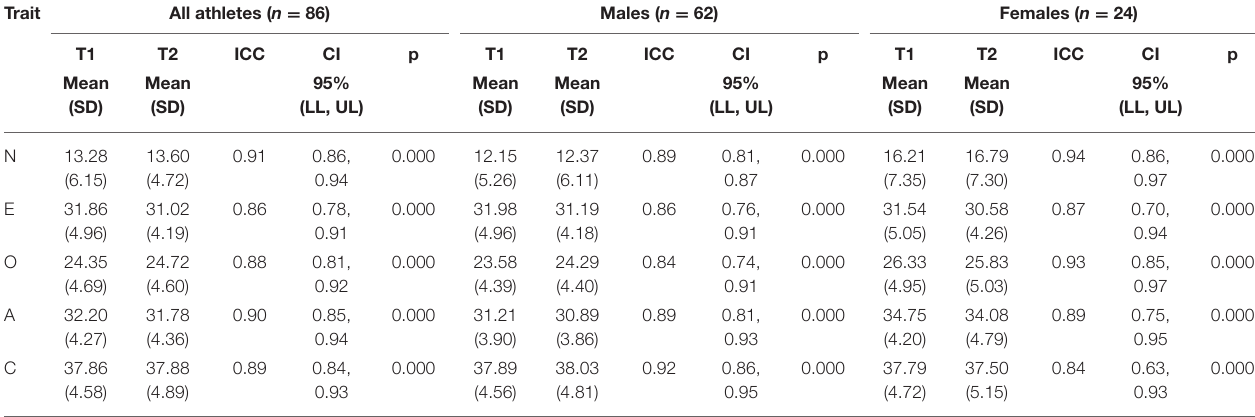
TABLE 3 | Test-retest reliability of NEO-FFI traits, separated by gender. Trait All athletes ( n =